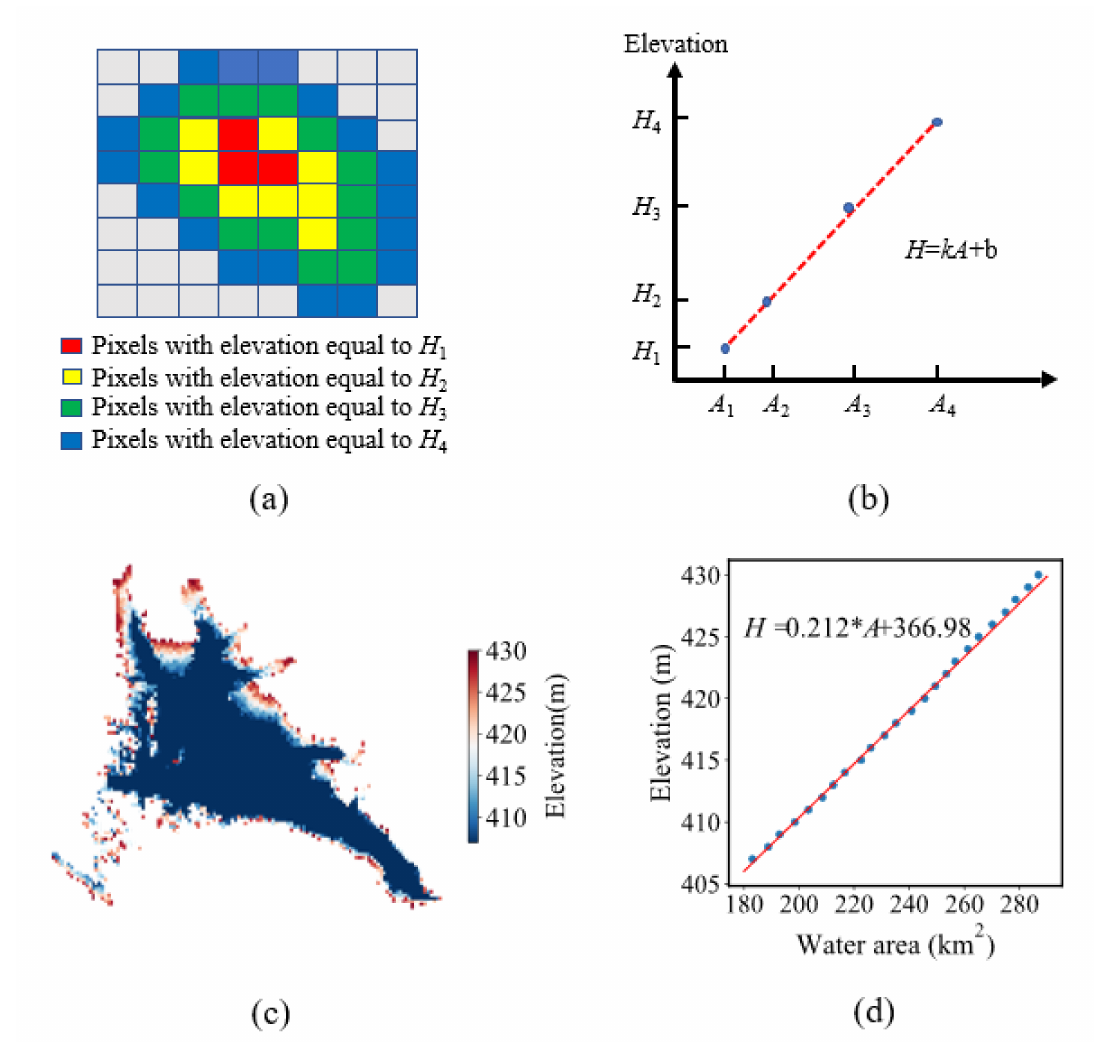
Figure 3. ( a ) A simplified example of a delineated reservoir from the SRTM Digital Elevation Model (DEM), where H 1 > H 2 > H 3 > H 4 ; ( b ) the corresponding A - H relationship inferred from a simplified example; ( c ) real example of a delineated reservoir from the SRTM DEM over the Pong reservoir; ( d )